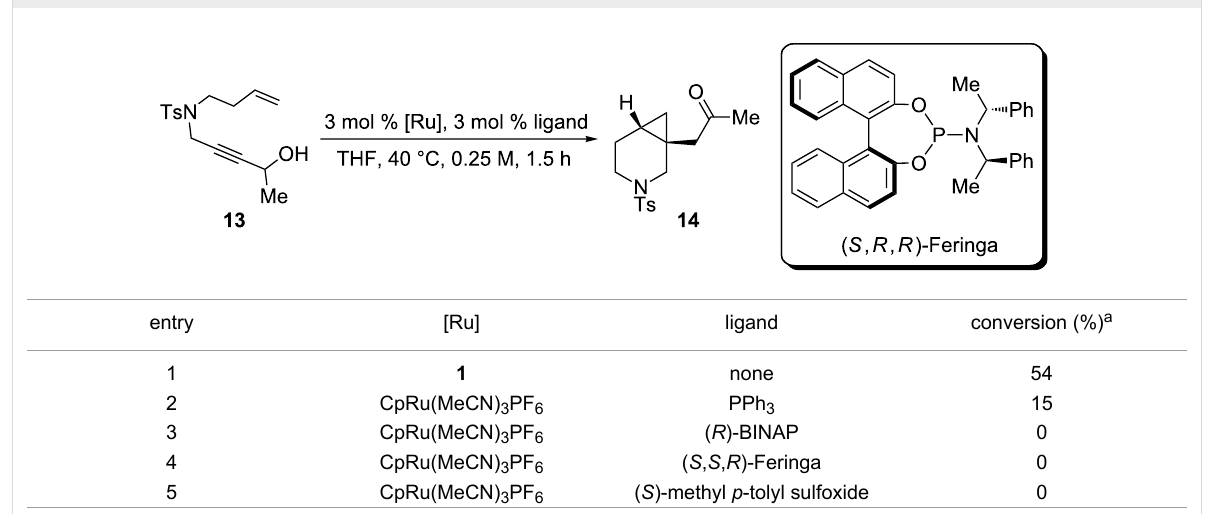
Table 4: Comparison of complex 1 to other catalyst systems as described in